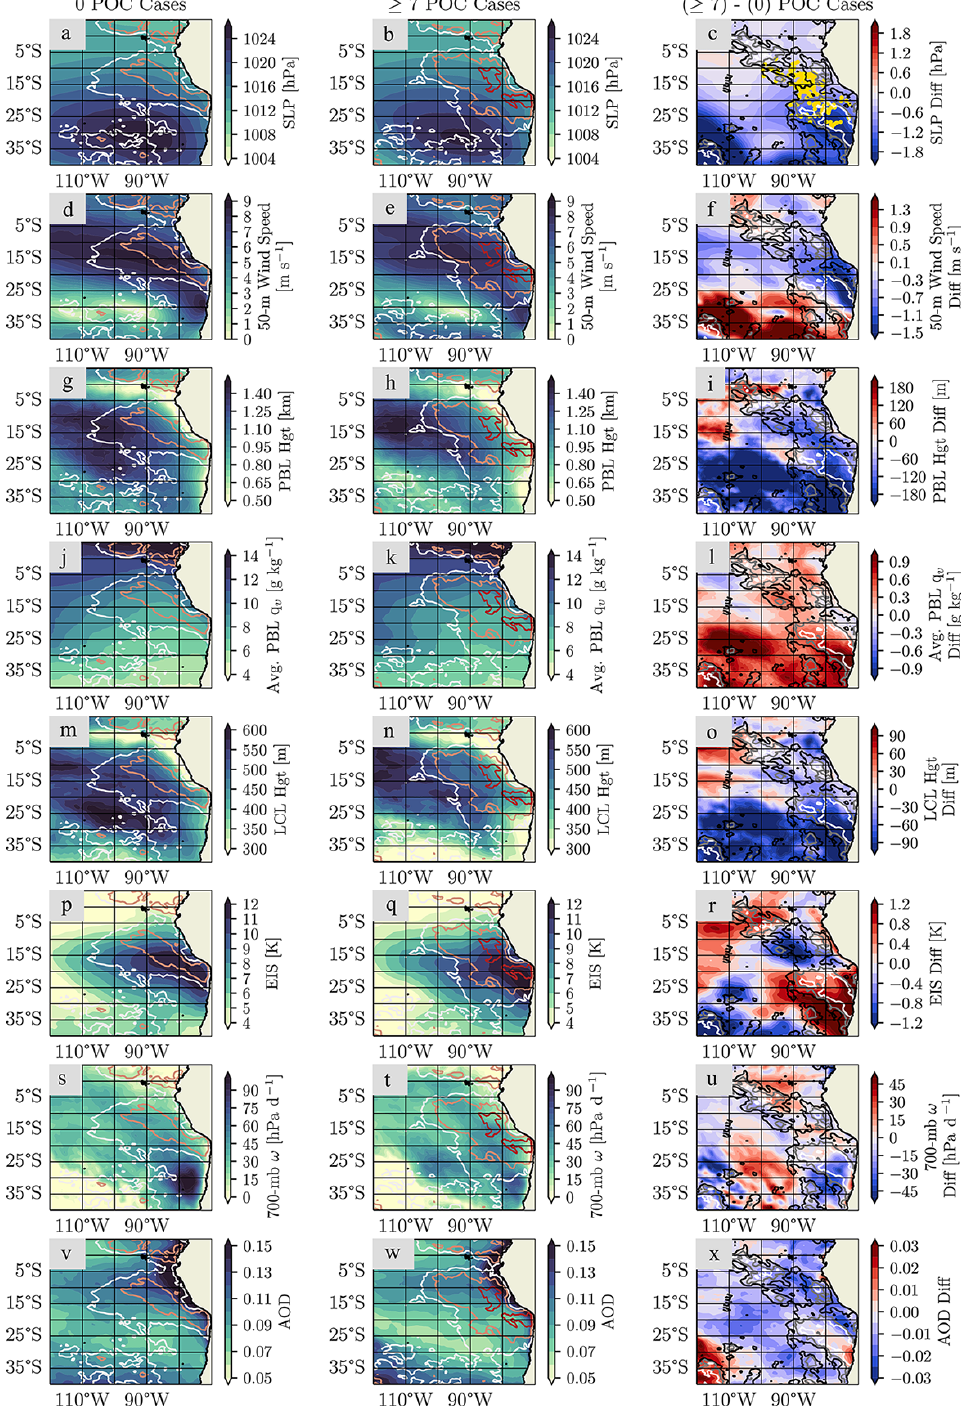
Figure 10. Average sea-level pressure (SLP; a ), 50m winds (d) , planetary boundary layer (PBL) height (g) , average PBL water vapor mixing ratio ( q v ; j ), lifted condensation level (LCL; m ), estimated inversion strength (EIS; p ), 700mb omega ( ω ; s ), and total column aerosol optical depth (AOD; v ) are shown in the first column for days when no POCs occur. The second column shows the same variables for days when > 7 POCs occur. The third column shows the difference between each variable for days with > 7 POCs and days with no POCs. The non-filled contours overlaid in all panels represent cloud fraction, where white represents 70%, orange represents 80%, and red represents 90%. The gold dots shown in (c) overlay the POC starting